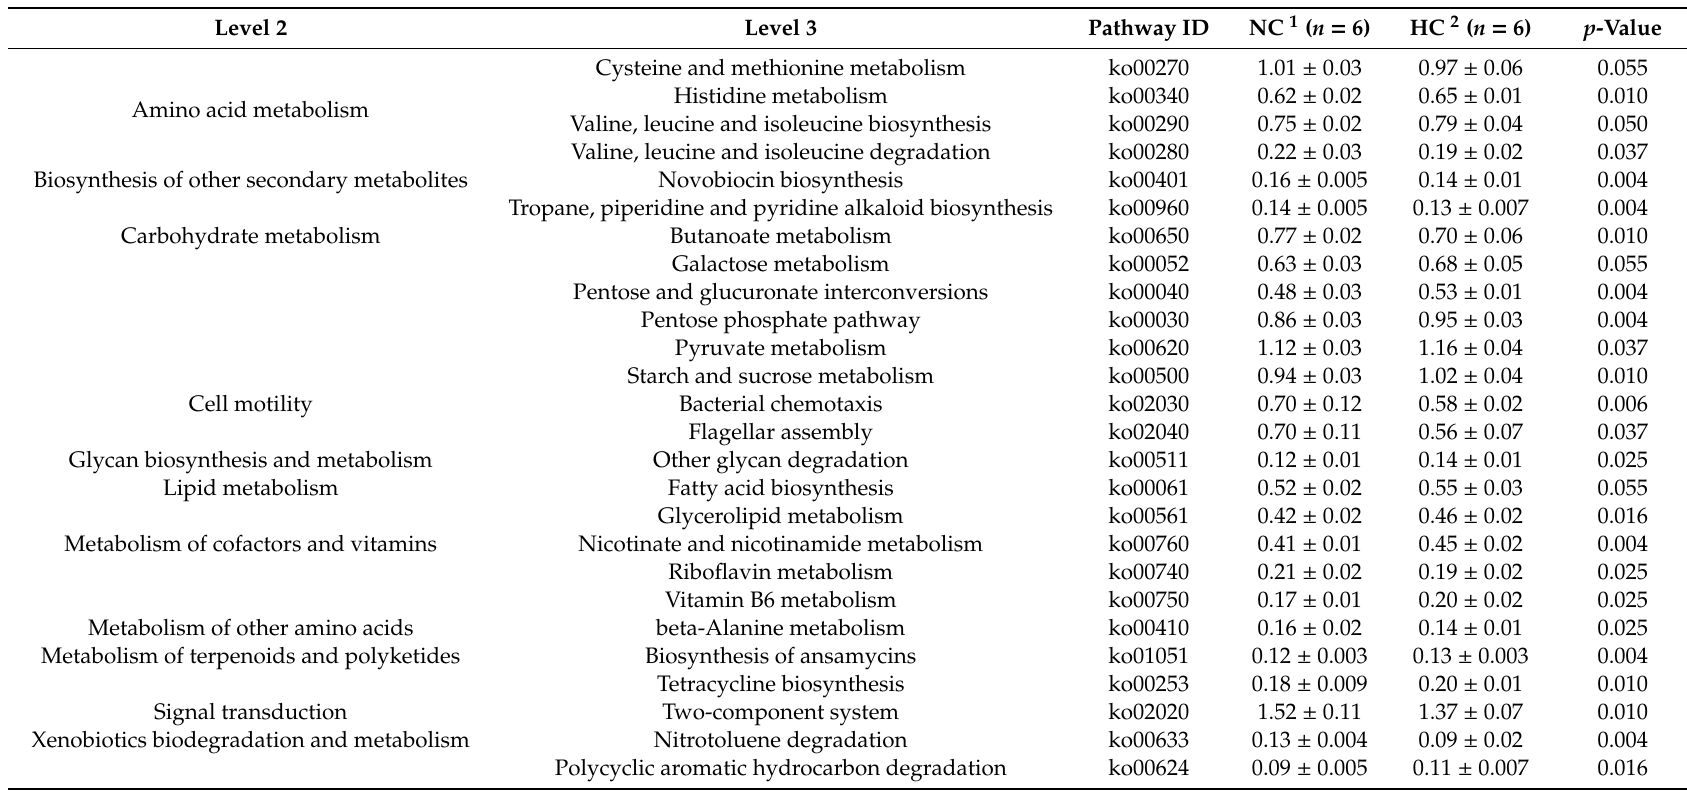
Table 5. KEGG pathways that showed di ff erent abundances (%) between ileal digesta microbiota in twelve goats fed the normal-concentrate (NC) and high-concentrate (HC)